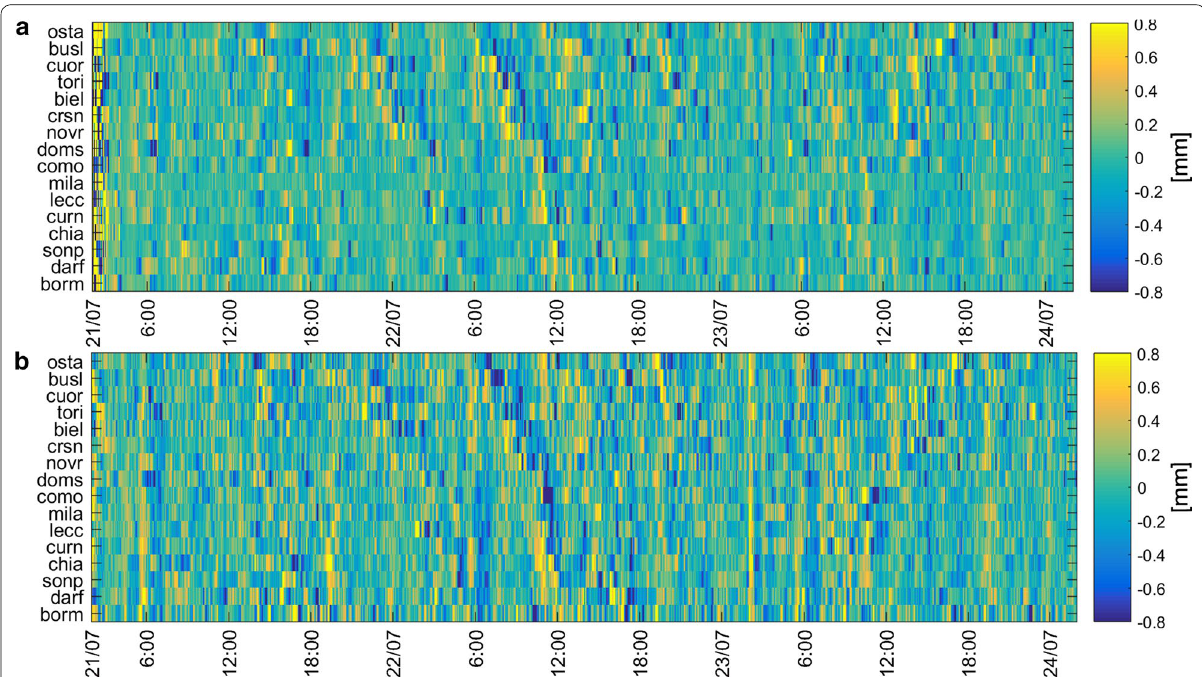
Fig. 6 Time variations in PWV goGPS ( a ) and PWV goGPSw ( b ). Each row of the matrix shows one station, identified by its four-letter code, and the stations are ordered from west to east. Time variation interval: 10 min. The color scale shows PWV variations in (mm), where increases in PWV are shown in yellow and decreases are shown in